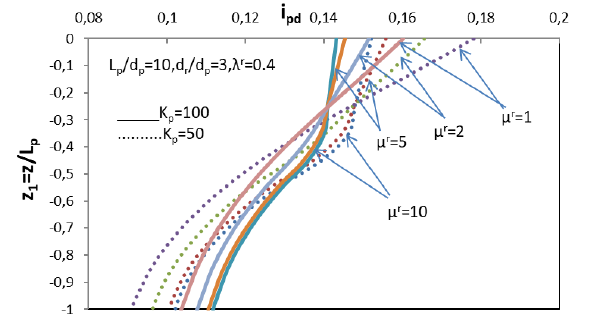
Figure 16: Variation of SIF for any depth, i (πd L )/F, z =z/L –effect of stiffness factor, μ r , on homogeneous GP–raft and r p p 1 p partially strengthened GP–raft (L